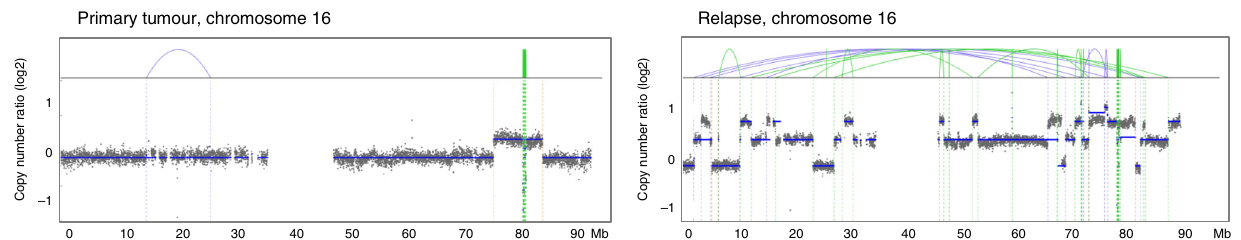
Fig. 8 Longitudinal analysis of chromothriptic patterns in matched primary-relapse pairs and different metastases from the same patients. Representative examples of the evolution of chromothriptic patterns are shown. Analyses of the evolution of chromothriptic patterns for all matched pairs ( n = 41, with 24 pairs showing chromothripsis) are shown in Supplementary Data 5. Example 2 is from a different patient cohort because examples for this speci fi c scenario with available whole-genome sequences for both time points were lacking. Blue lines indicate inversions, green lines indicate break ends, brown lines indicate translocations and orange lines indicate copy-number